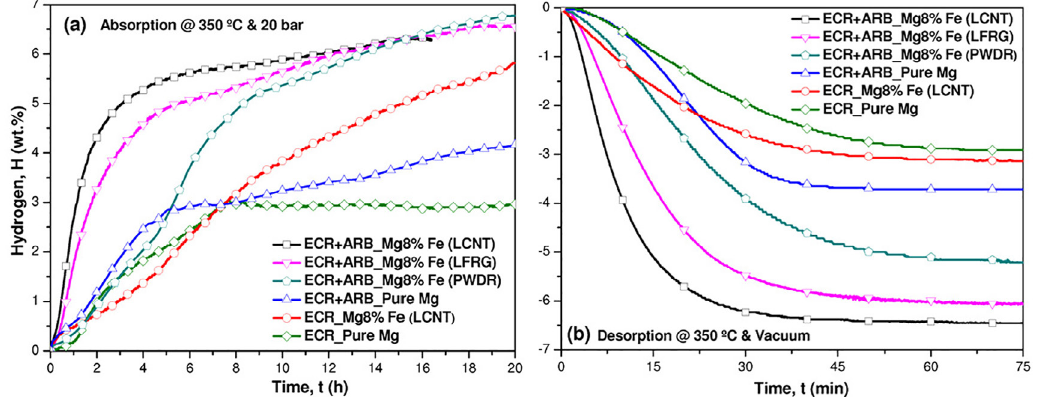
Figure 7. Knetic curves of pure Mg and Mg-8 mol% Fe (LCNT, LFRG and PWDR) processed by ECR and ECR+ARB, (a) for absorption @ 350 ºC/20 bar